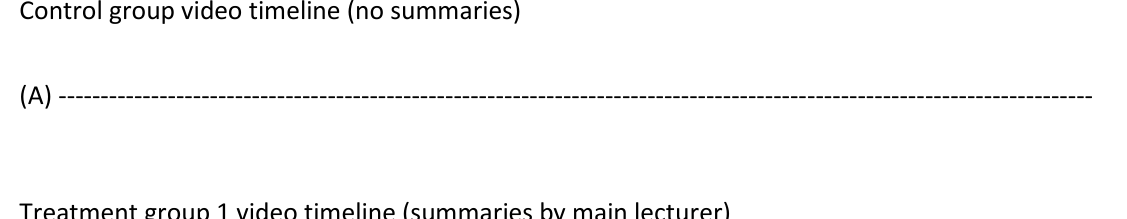
Control group video timeline (no summaries)